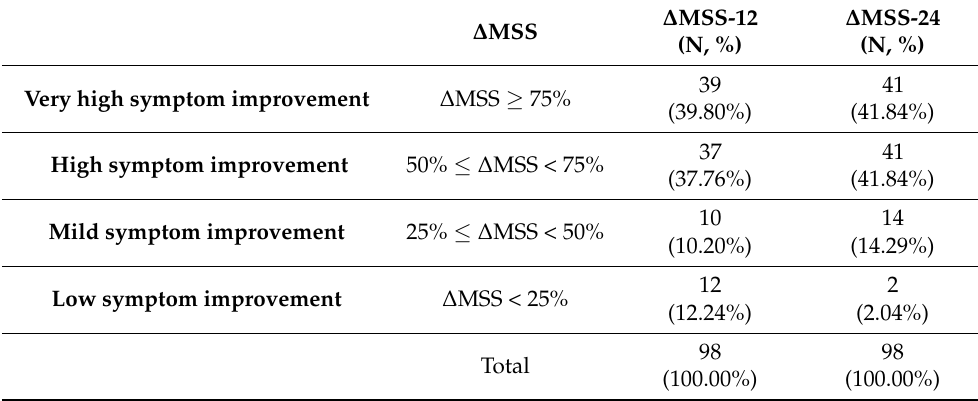
Table 1. Classification of patients treated with sublingual immunotherapy (SLIT) based on ∆ MSS. Patients were stratified based on ∆ MSS to identify patients who had a better clinical response as compared to those with a poor response to SLIT. ∆ MSS-12: evaluation after 12 months of SLIT treatment; ∆ MSS-24: evaluation after 24 months of SLIT